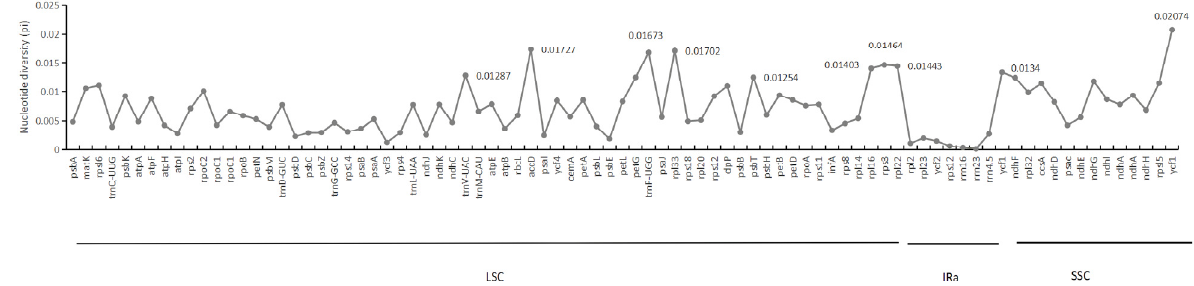
Figure 3. The nucleotide diversity ( π ) of coding regions among the seven Euonymus species.